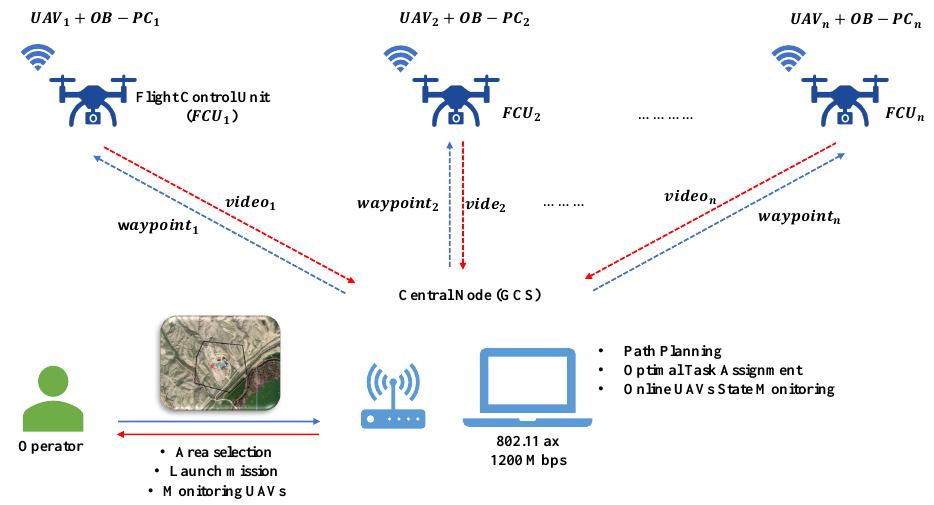
Figure 3. Architecture